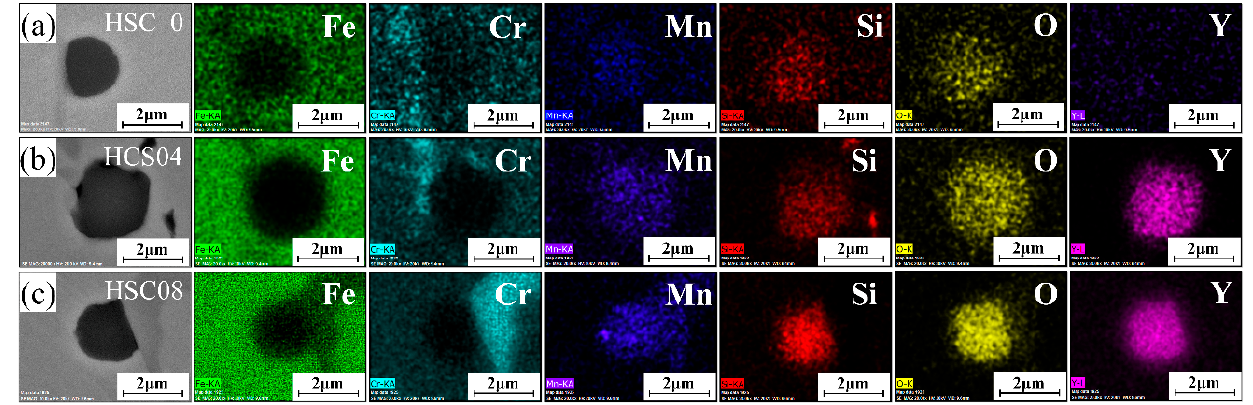
Figure 4. ( a ) XRD spectra and phase composition of the alloy powder samples, ( b ) XRD spectra and phase composition of the coating samples.